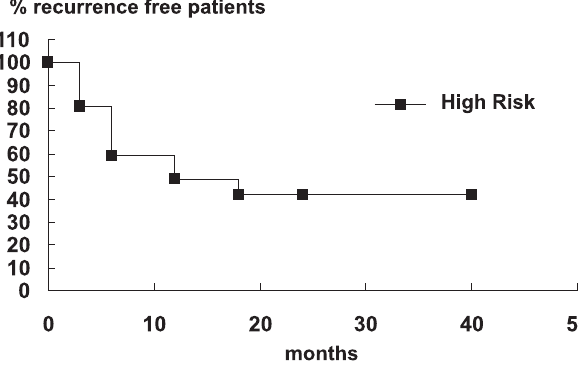
Figure 1 - Kaplan Mayer curve showing recurrence based on PSA for 21 high-risk prostate cancer patients